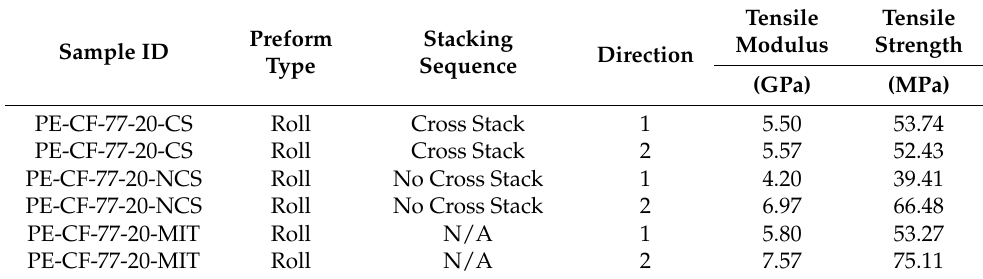
Table 8. Tensile modulus and strength—PE-CF (preform ‘Roll’).